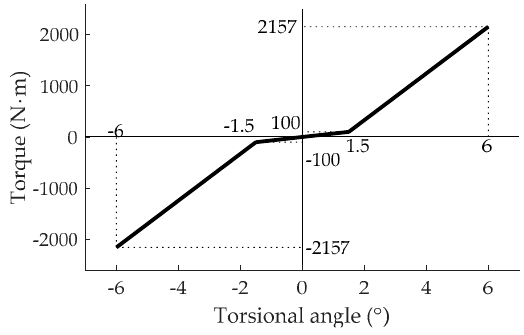
Figure B2. Clutch stiffness curve. Figure A6. Clutch stiffness